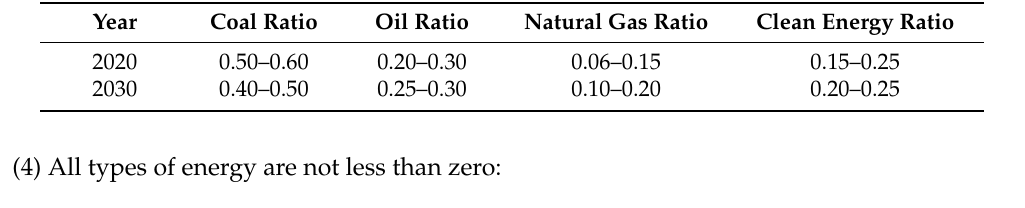
Table 4. The proportions of primary energy consumption for 2020 and